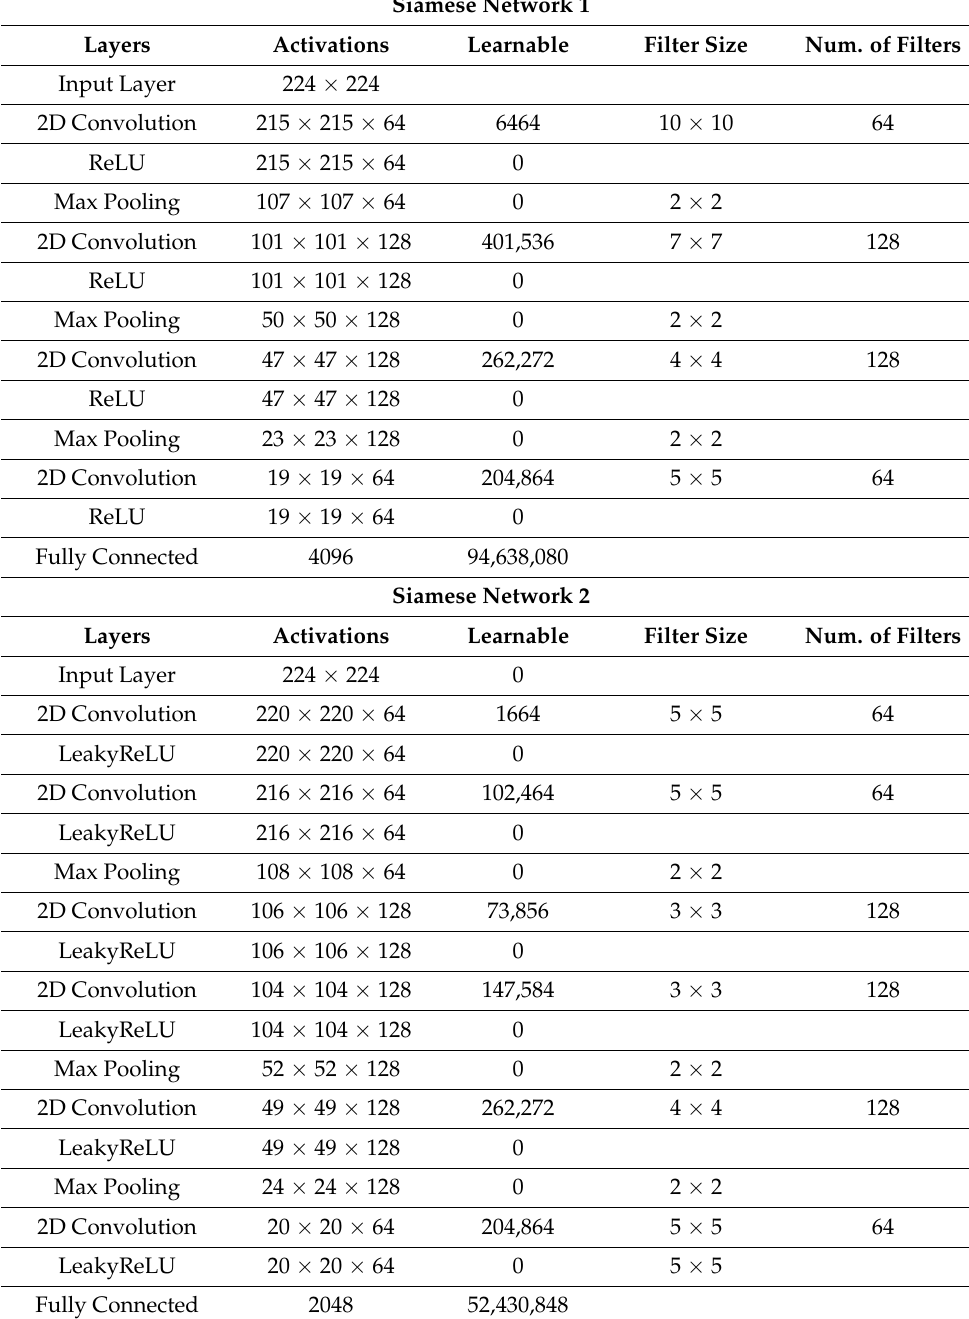
Table 1. CNN Siamese Networks (1–8)